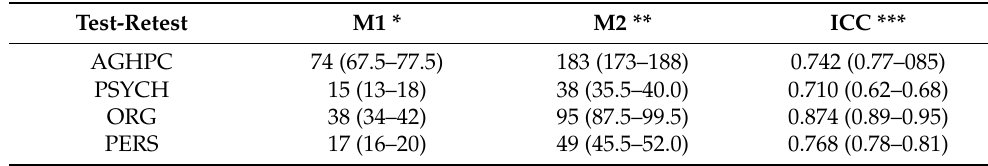
Table 5. Median (25th–75th percentile) of the temporal stability distribution for Adherence to Good Hospital Practices for COVID-19 and its domains ( n =